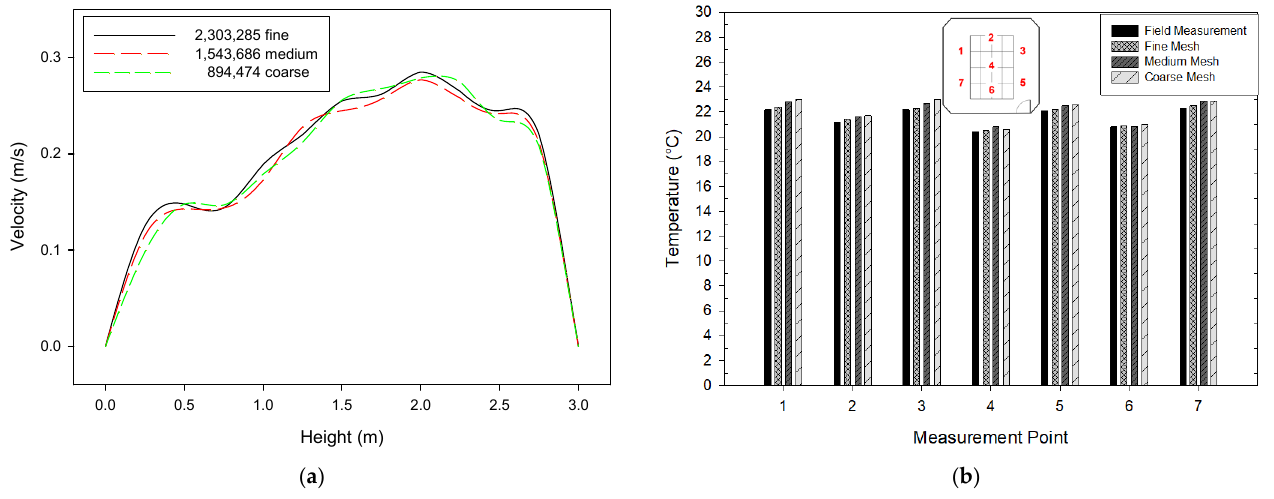
Figure 4. Grid independence test and validation of the measurement and simulation. ( a ) Grid independence test; ( b ) Val- idation.